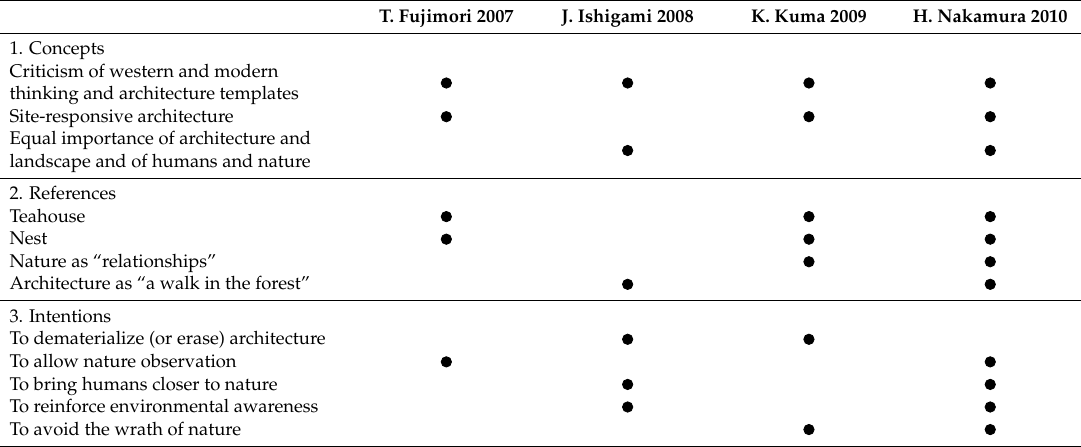
Table 1. Brief relation of concepts, standpoints, and intentions in four contemporary Japanese architectural